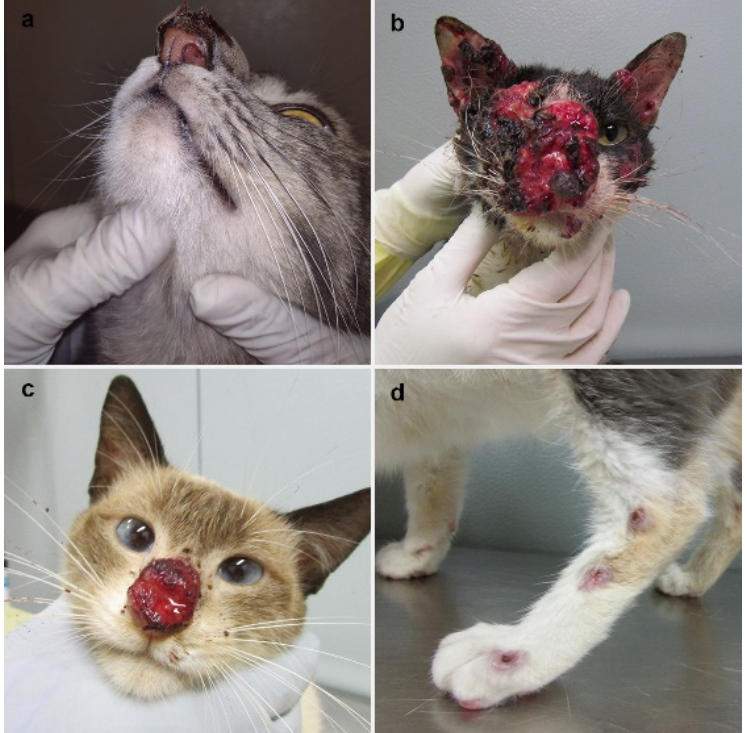
Figure 1. Clinical presentations of feline sporotrichosis caused by Sporothrix brasiliensis . ( a ) Swelling of the nasal bridge with crusted skin ulcer and nasal mucosa lesion causing narrowing of the left nostril. ( b ) Multiple skin lesions partially covered by hematic crusts draining serosanguinous exudate on the cephalic region with the involvement of nasal/ocular mucosa. ( c ) Crusted skin ulcer on the nasal bridge and nasal planum, draining serosanguinous exudate. ( d ) Ascending nodular lymphangitis on the left hindlimb.